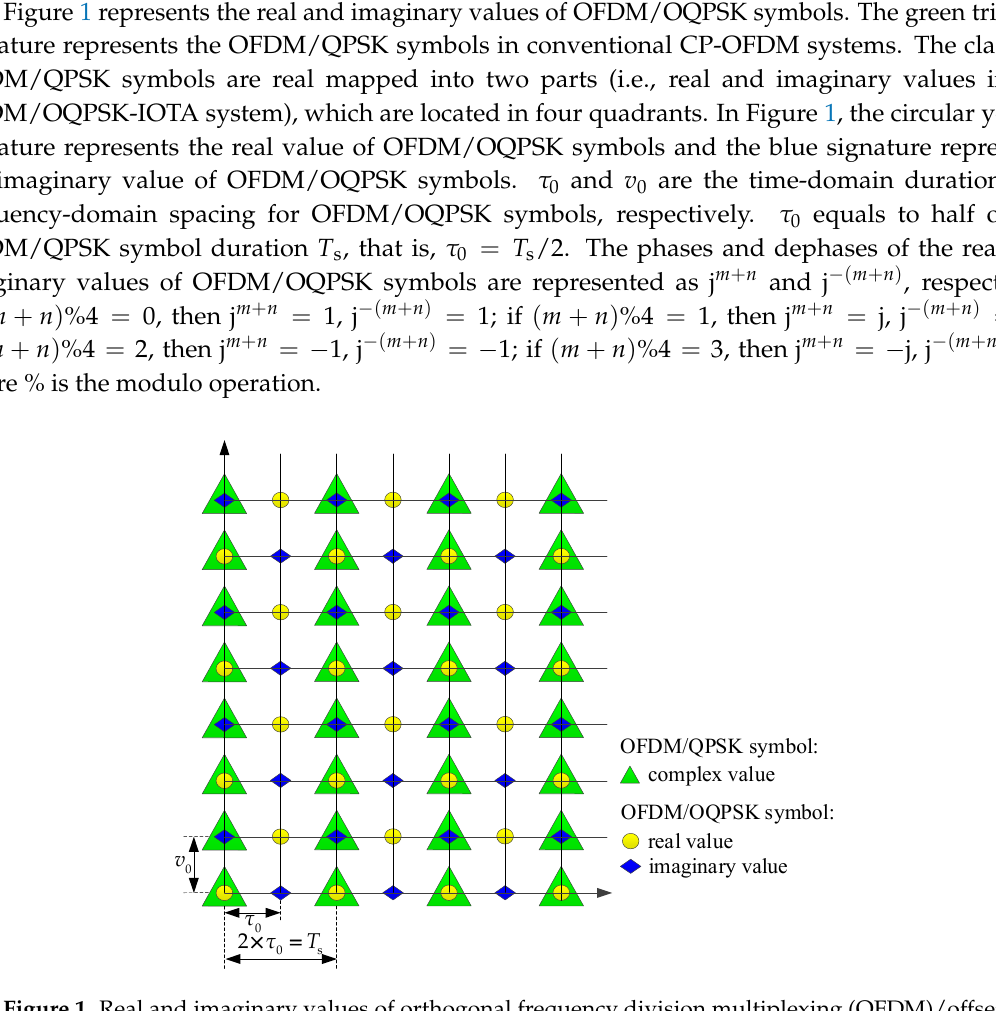
Figure 1. Real and imaginary values of orthogonal frequency division multiplexing (OFDM)/offset quadrature phase shift keying (OQPSK) symbols.